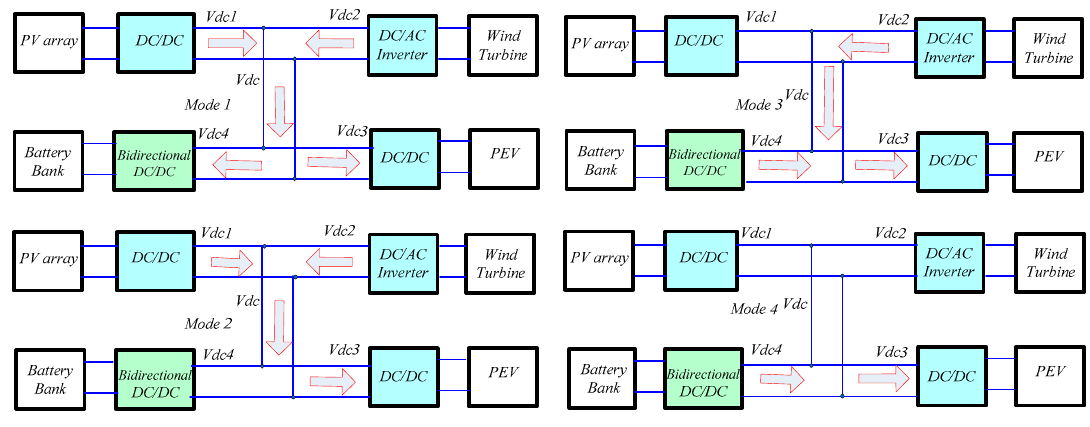
Figure 9. Di ff erent modes of Figure 9. Different modes of operation.